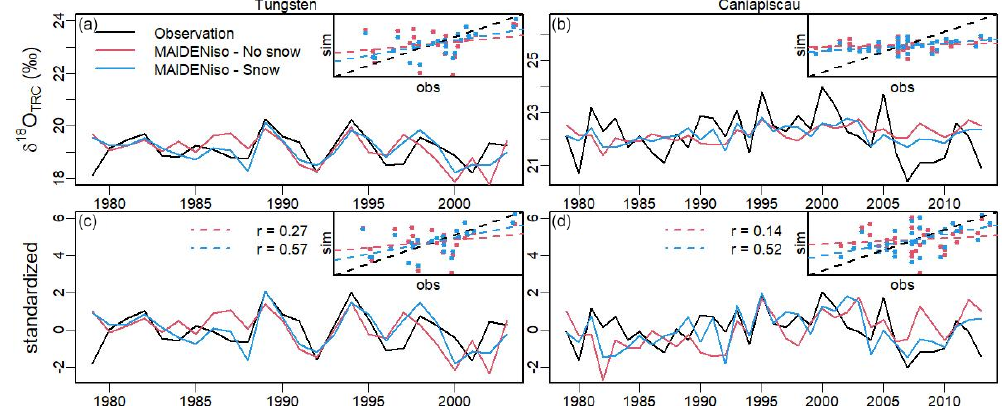
Figure 6. The δ 18 O TRC observed (black) and simulated by the versions of MAIDENiso without (red) and with (blue) snow, using the calibrated parameters for (a, c) Tungsten and (b, d) Caniapiscau. Top panels (a, b) show the raw δ 18 O TRC series; bottom panels (c, d) show the standardized δ 18 O TRC series. Top-right inner panels show the scatter diagrams of the simulated (by both versions of the model, red for the version without snow and blue for the version with snow) and observed values of δ 18 O TRC , with dashed lines showing the linear regression models. Correlations are identical for the raw series (top panels a and b ) and the standardized series (bottom panels c and d ).